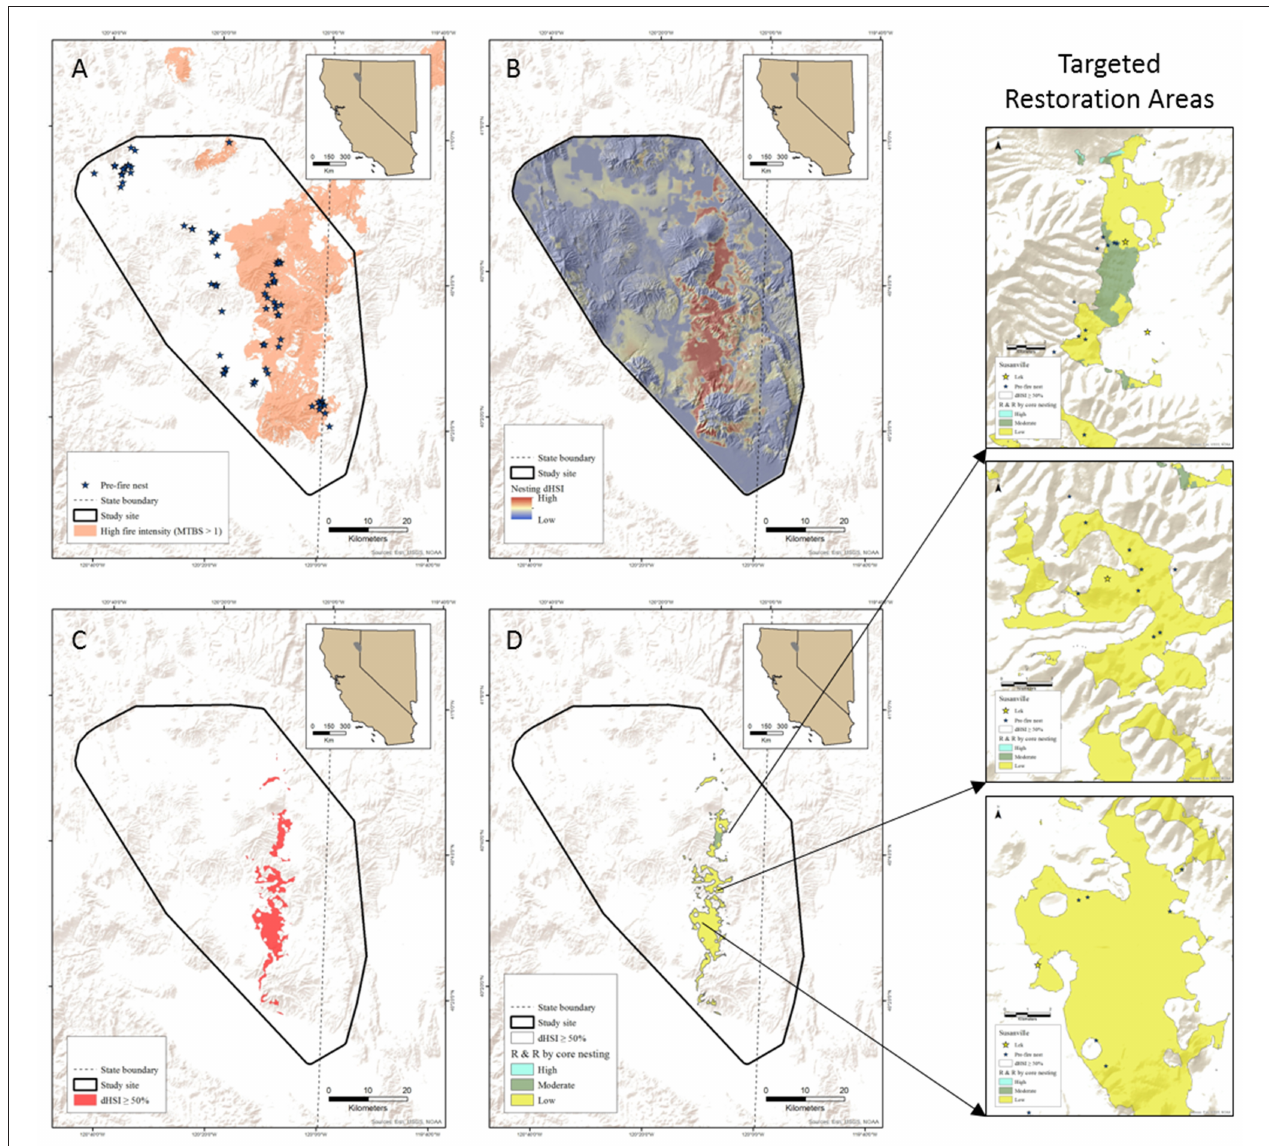
FIGURE 9 | Example of identifying areas for targeted restoration of sage-grouse nesting habitat affected by the Rush Fire in northeastern California. Pre-fire sage-grouse nest locations (A) inform a resource selection function of habitat loss post-fire (B) , which is categorized by the 50th percentile representing core loss (C) and intersected with RandR (D)